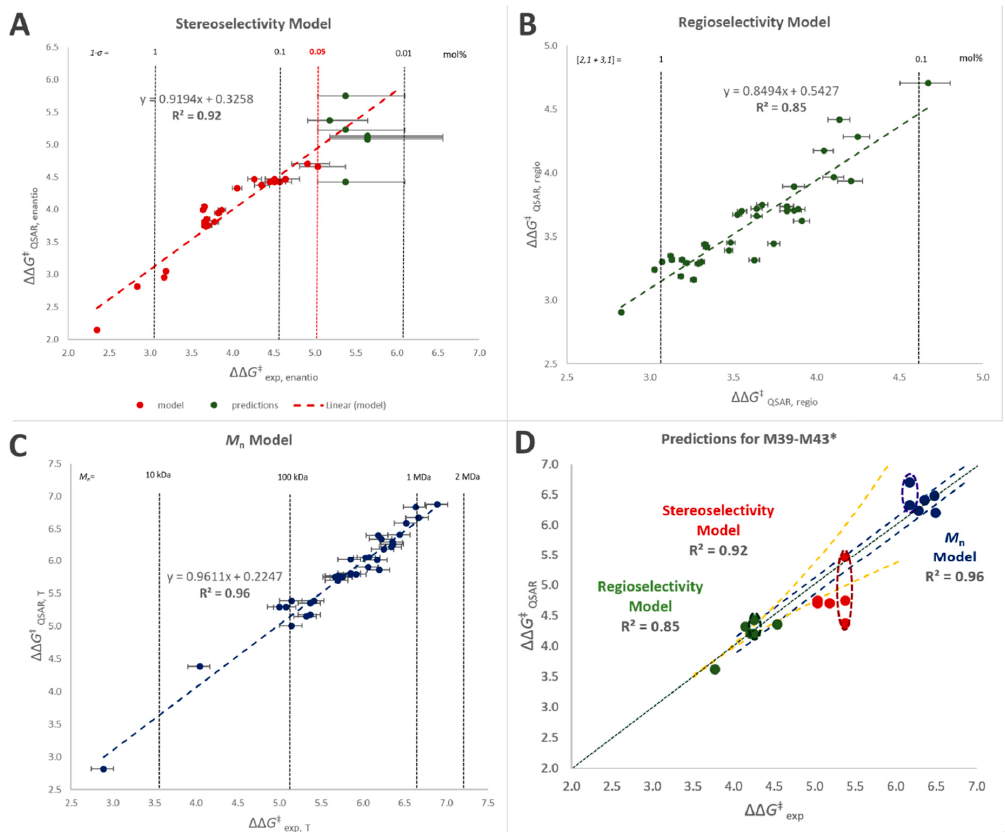
Figure 5. ( A – C ) QSAR-predicted vs. observed ∆∆ G ‡ values (in kcal / mol) for the catalyst training set M1 – M38 (Figure 1 and Table 1): stereoselectivity ( A ); regioselectivity ( B ); and polymer molar mass capability ( C ). The model for stereoselectivity was built using the available experimental data for (1 − σ ) ≥ 0.05% (see text). ( D ) QSAR-predicted vs. observed ∆∆ G ‡ values for the catalyst validation set M39 – M43 (Figure 6 and Table 8): stereoselectivity (red dots); regioselectivity (green dots); and polymer molar mass capability (blue dots). Green dotted line = perfect agreement. In all cases, error bars (yellow dotted lines: for stereo- and regioselectivity, blue dotted lines for molar mass capability) reflect experimental uncertainty (see Tables 1 and 8). * For M43 two conformational isomers of comparable stability were identified by DFT modeling (see SI); the calculated values of all polymer properties of interest are reported for each isomer, inscribed into dashed ellipses.